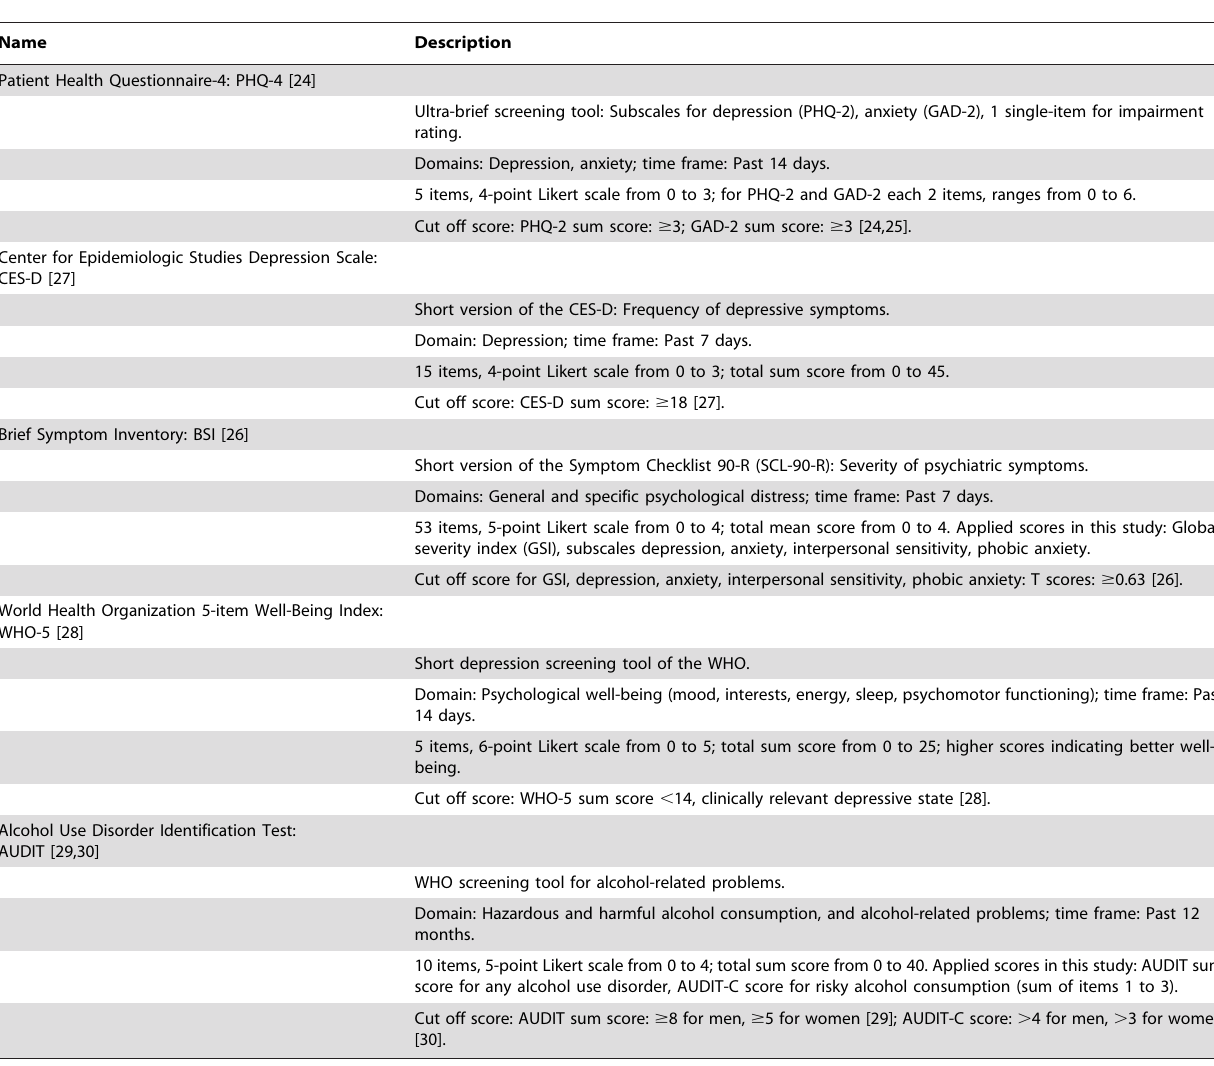
Table 1. Standardized self-report questionnaires that were assessed at baseline (T1) and 6-month follow-up (T2).